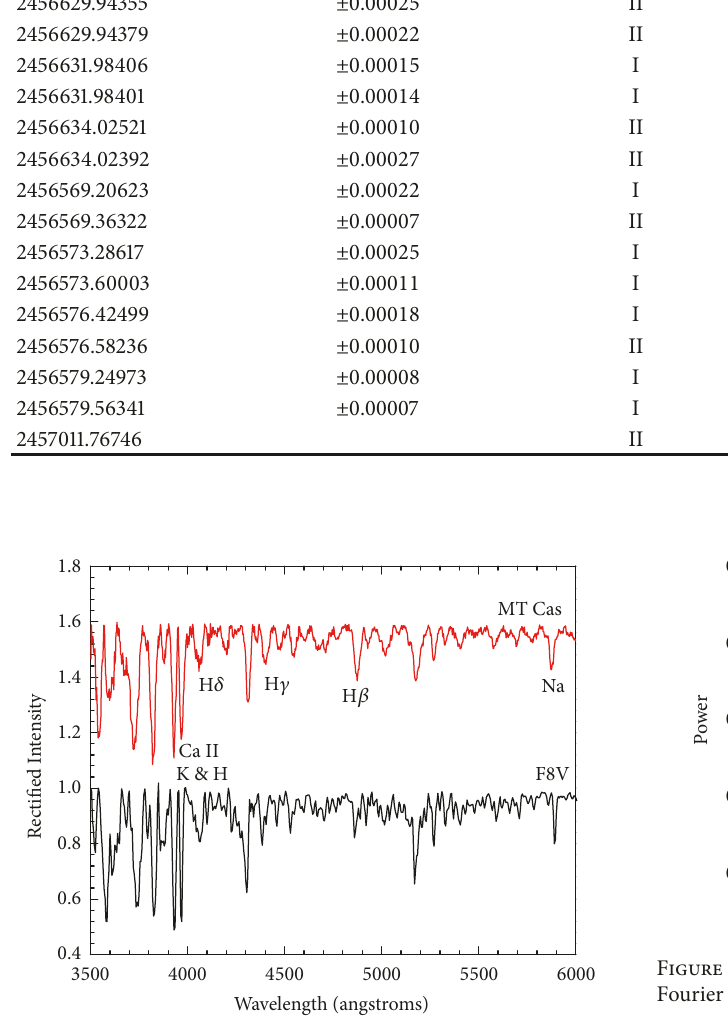
Figure 2: Spectroscopic observation for MT Cas, observed by the 2.4-m telescope at Lijiang station of YNAO on October 22, 2018.